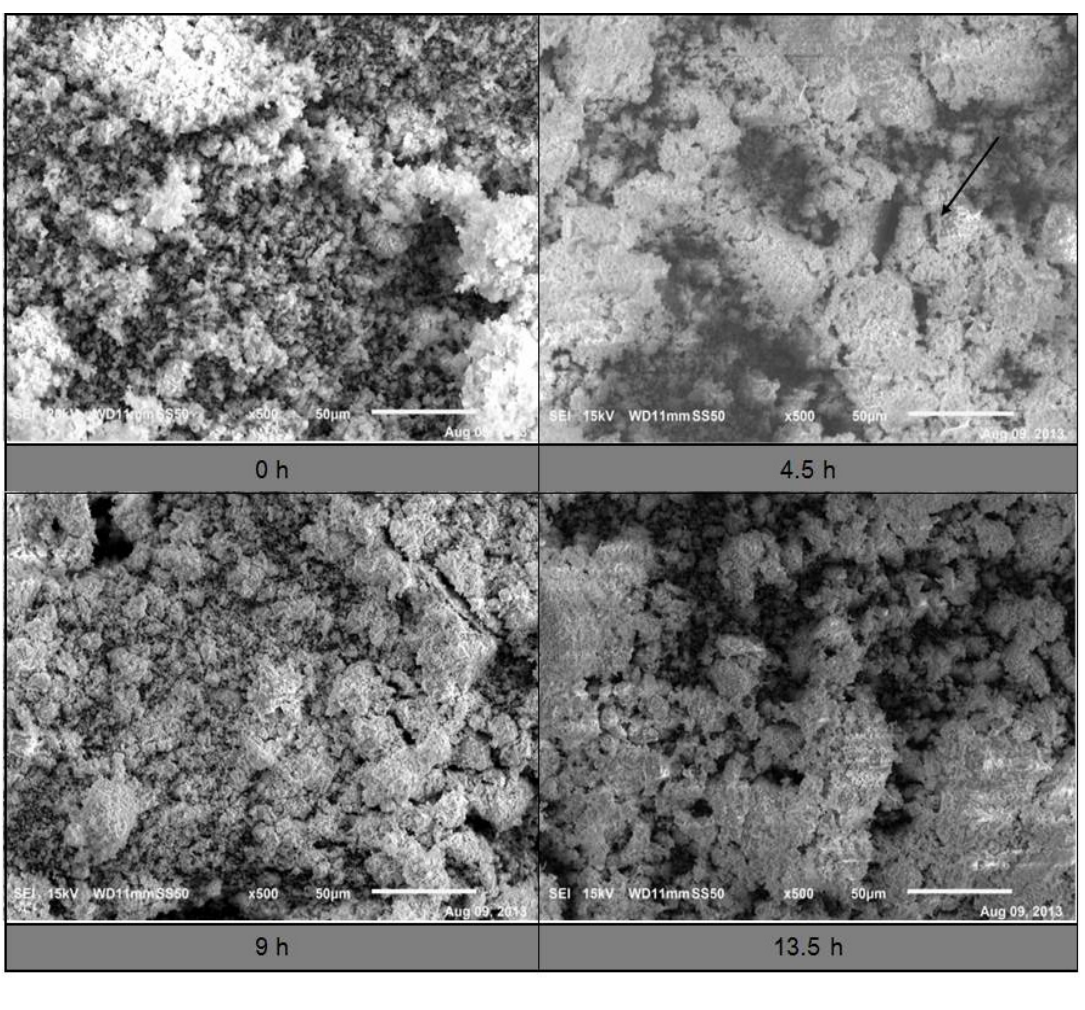
Fig. 7 SEM images of Nd